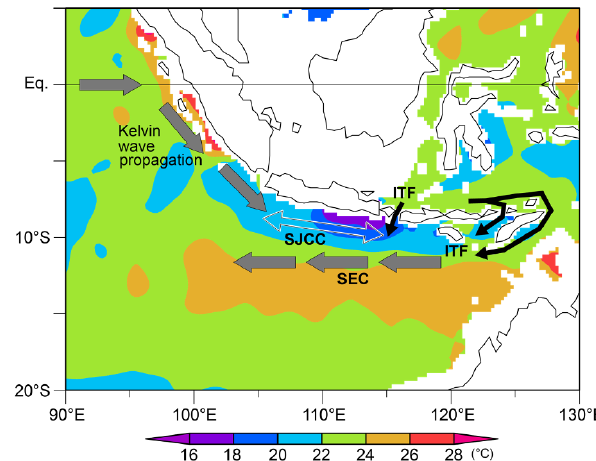
Figure 20. Map of the Sumatra–Java upwelling region and sur- rounding area. Background colour shade shows July–August– September mean climatological temperature at 100m depth from World Ocean Atlas 2018 (Locarnini et al., 2018). Grey, black, and unfilled arrows schematically indicate representative surface cur- rents near the upwelling system (SEC: South Equatorial Current; SJCC: South Java Coastal Current; ITF: Indonesian Throughflow) and a route of Kelvin wave propagation from the equatorial region down to the Sumatra and Java